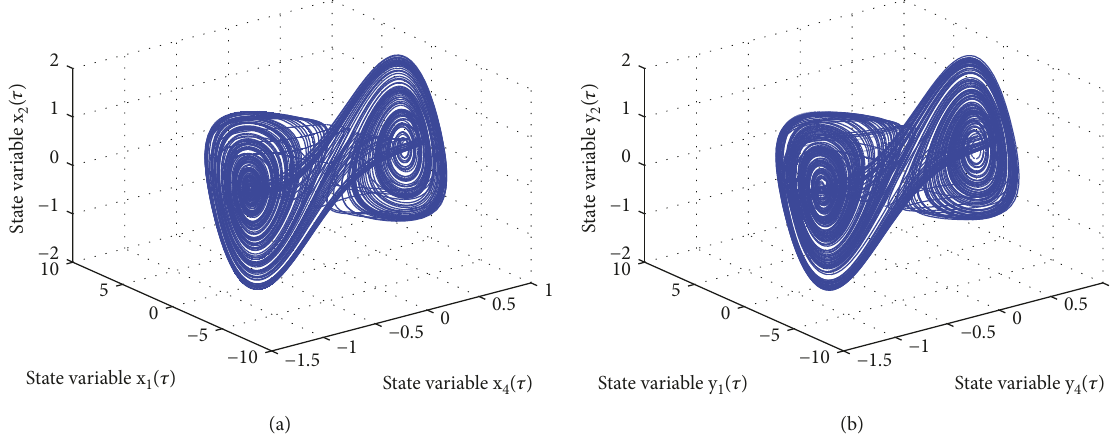
τ = sin 2 x τ and K derived by Proposition 2. (b) Simulation result for slave 4 4